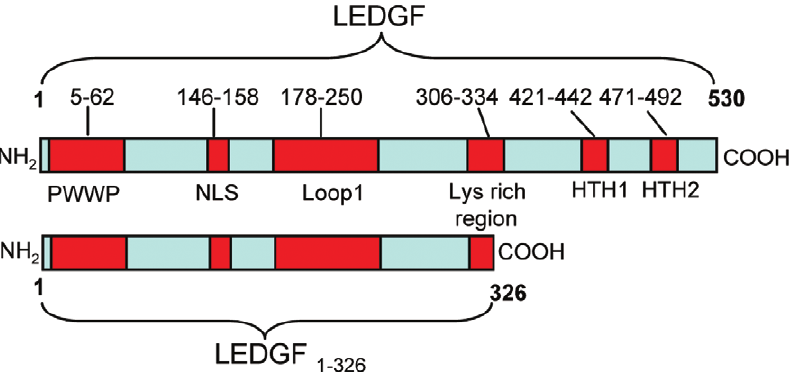
Figure 1. Schematic representation of LEDGF domains. PWWP, DNA binding domain (aa5–62); Nuclear localization signal (aa148–156); Loop1, contains AT hook like domain (aa178–250), lysine rich coiled coil domain (aa216–343), HTH1, Helix-turn-helix domain (aa421–442); HTH2, Helix-turn- helix domain (aa471–492).